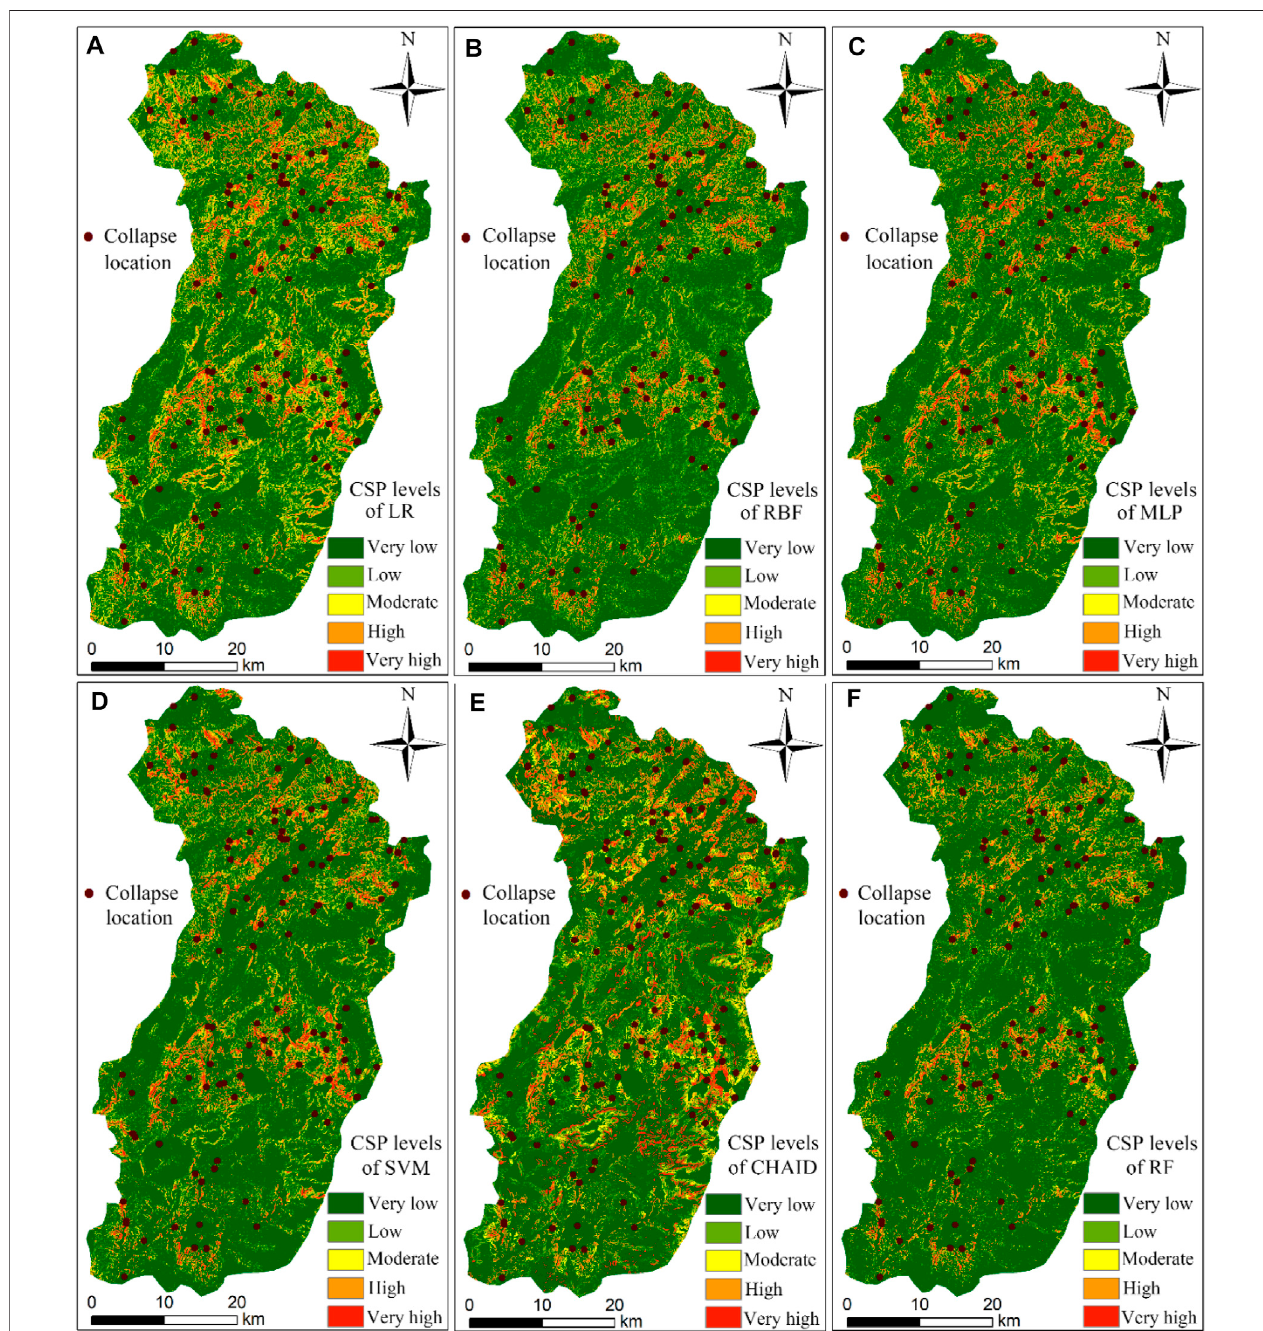
FIGURE 6 | CSP levels using machine learning models: (A) LR, (B) RBF, (C) MLP, (D) SVM, (E) CHAID, and (F) RF models.